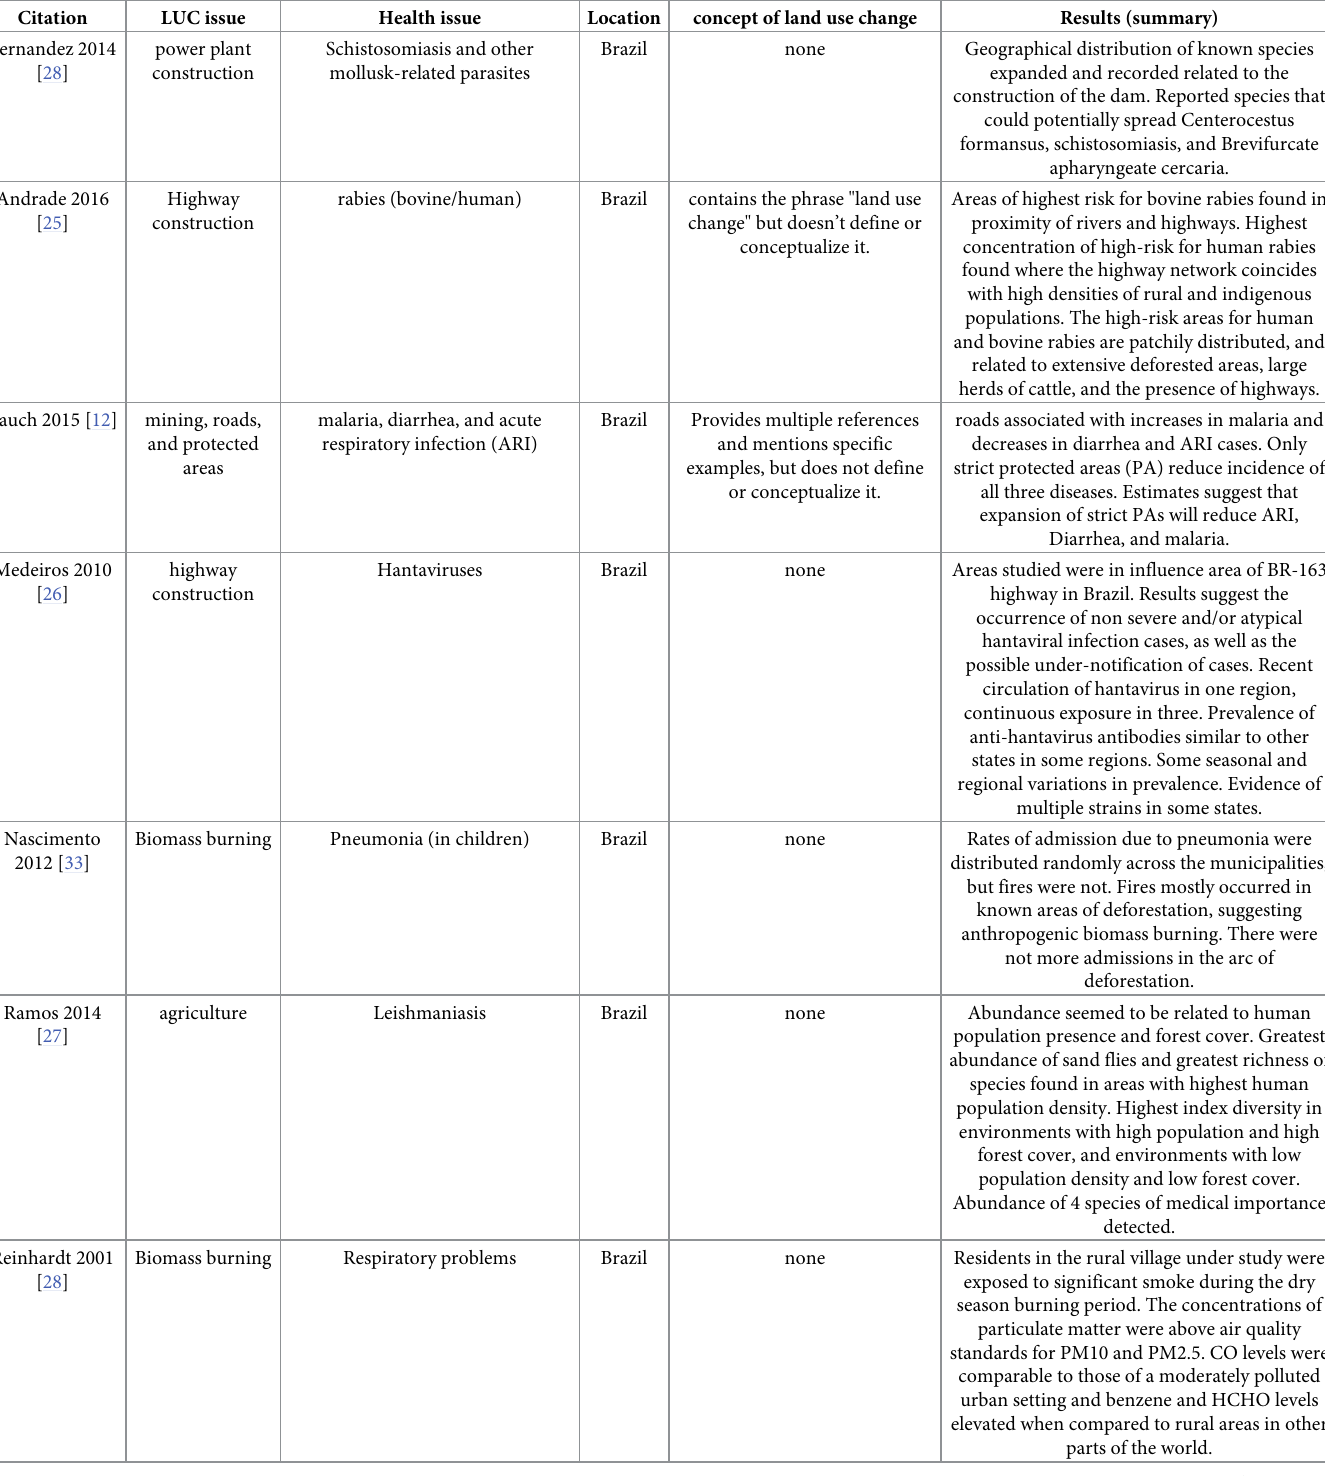
Table 2. Summary of selected